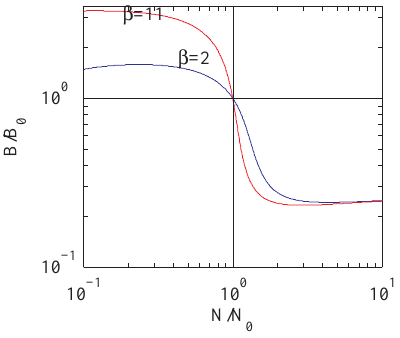
Fig. 8. Comparison of solitons measured by Cluster-2 at time 22:14:10–22:15:05UT with a numerical solution computed for pa- rameters in Fig. 7, with β ⊥ =11, and M =0.067. This solution corre- sponds to the position marked with asterisk in Fig. 3. The computed amplitude and polarization are plotted with red